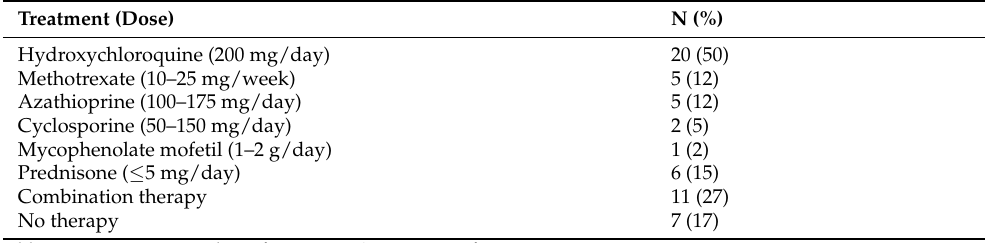
Table 2. Baseline characteristics of the study cohort–treatment.